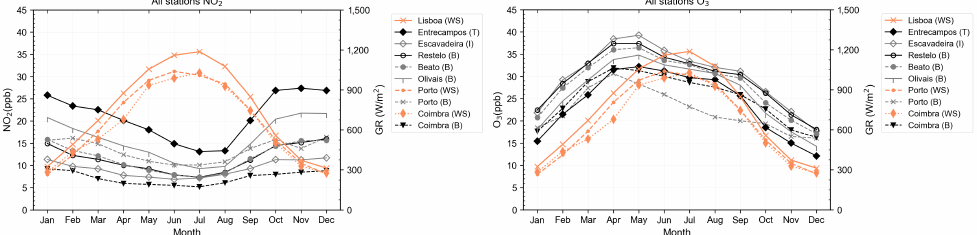
Figure 15. Mean values of all years data of all AQMS and WS. Monthly differences for NO 2 ( left ) and O 3 ( right ) are